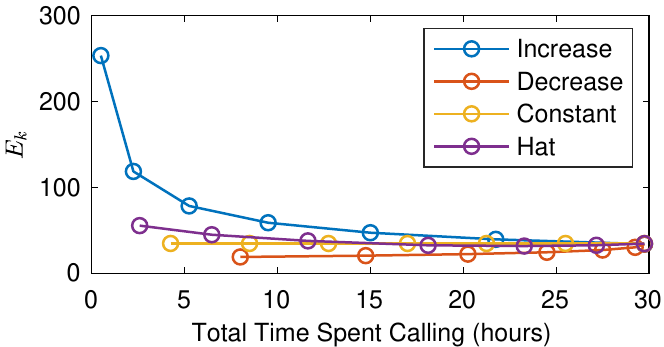
Figure 6. Effectiveness (mating probability/time spend calling) of the four female calling strategies. Each dot corresponds to a night. The increase strategy is the most effective for small calling times, while all strategies have similar effectiveness for large calling